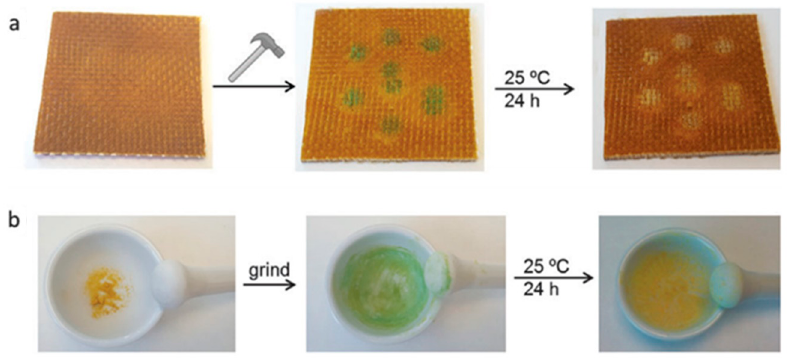
Figure 8. ( a ) Photographic sequence showing the glass-fiber composite being hit using a hammer, which resulted in the appearance of green spots, and, after 24 h at room-temperature, the green color disappeared. ( b ) Photographic sequence showing how cured epoxy vitrimer in the form of powder became green after grinding in a mortar. After 24 h at room-temperature the green color disappeared (reproduced from [123] with permission from Royal Society of Chemistry).